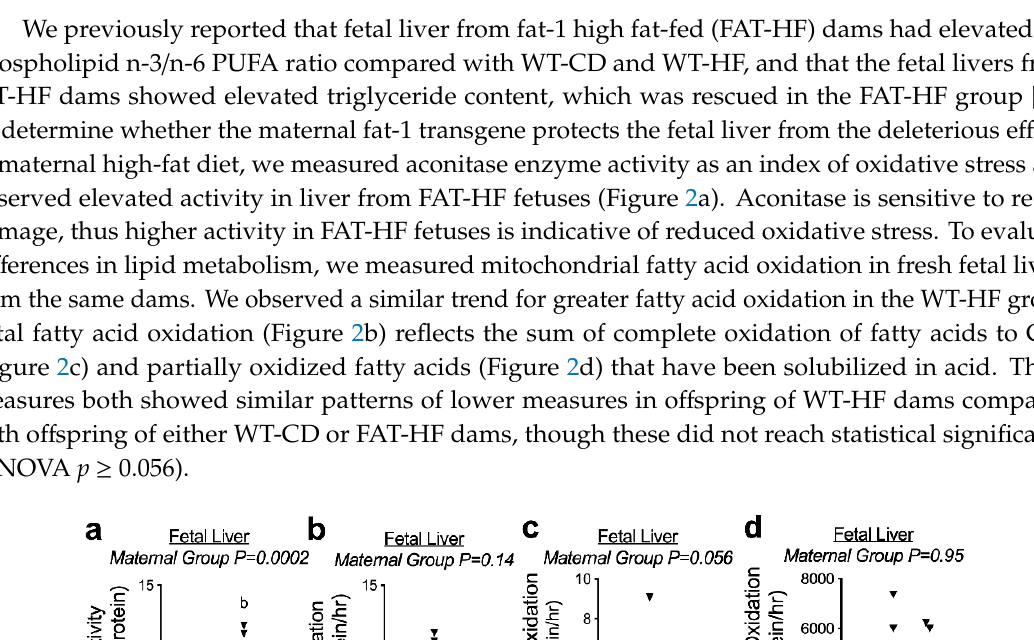
e ff ect of maternal group (WT-CD, WT-HF, FAT-HF) on weight gain in male and female o ff